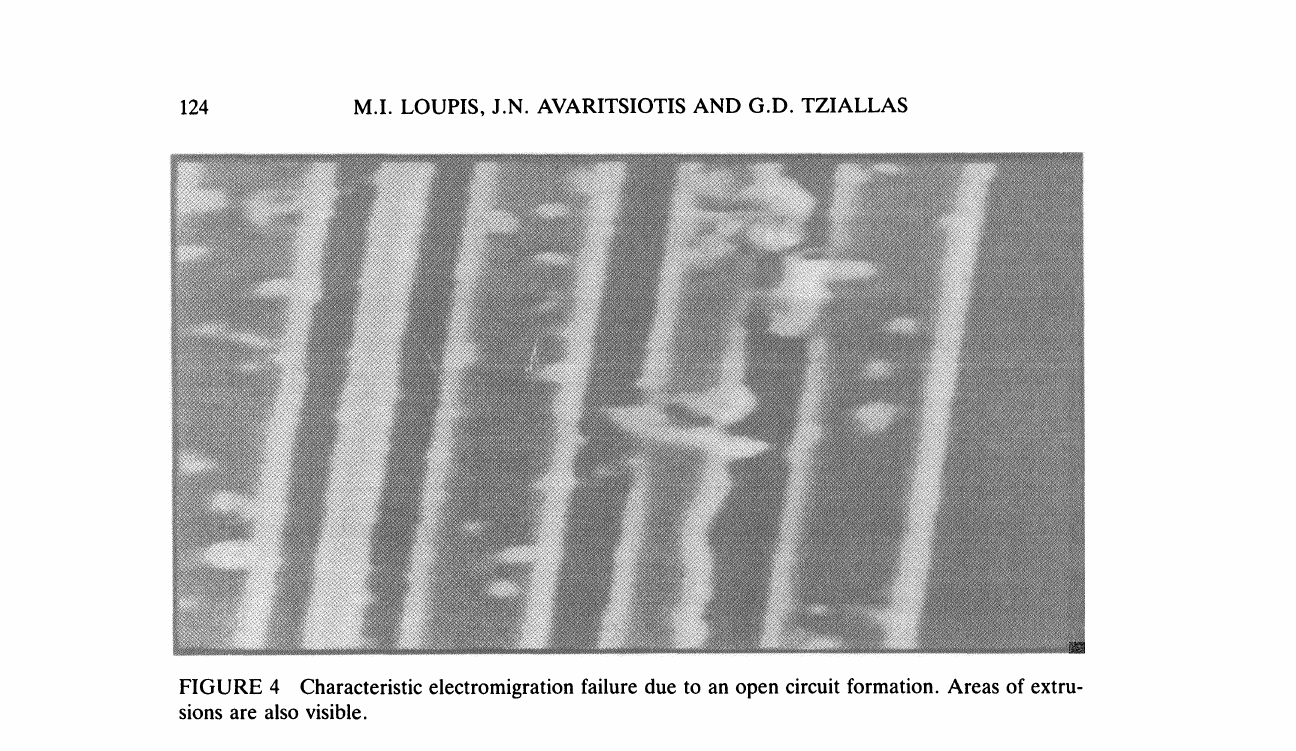
FIGURE 4 Characteristic electromigration failure due to an open circuit formation. Areas of extru- sions are also visible.